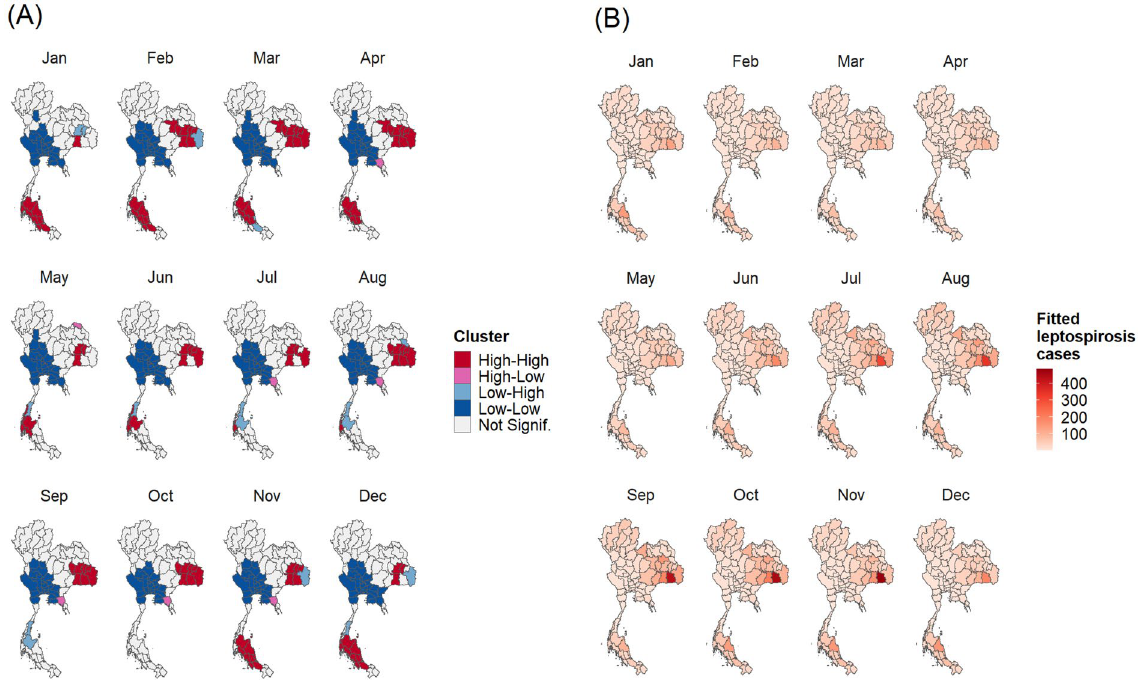
Figure 3. Plots of monthly spatial clustering of incidence rate as determined by LISA ( A ) and monthly leptospirosis cases estimated by the final GLMM ( B ). Maps created using R Program version 4.0.3 (https:// www.r- proje ct. org/).